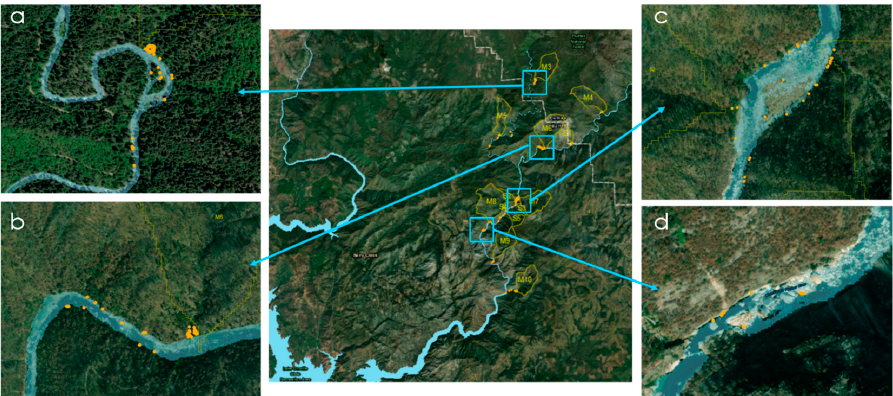
Figure 10. Potential deposition locations for LWD within the MF Feather River. ( a ) LWD deposited on meander bend and island. ( b ) LWD trapped above flow height and along banks entering a meander. ( c ) LWD trapped on islands and in areas where the channel expands at the lateral extent. ( d ) LWD trapped on rocks.